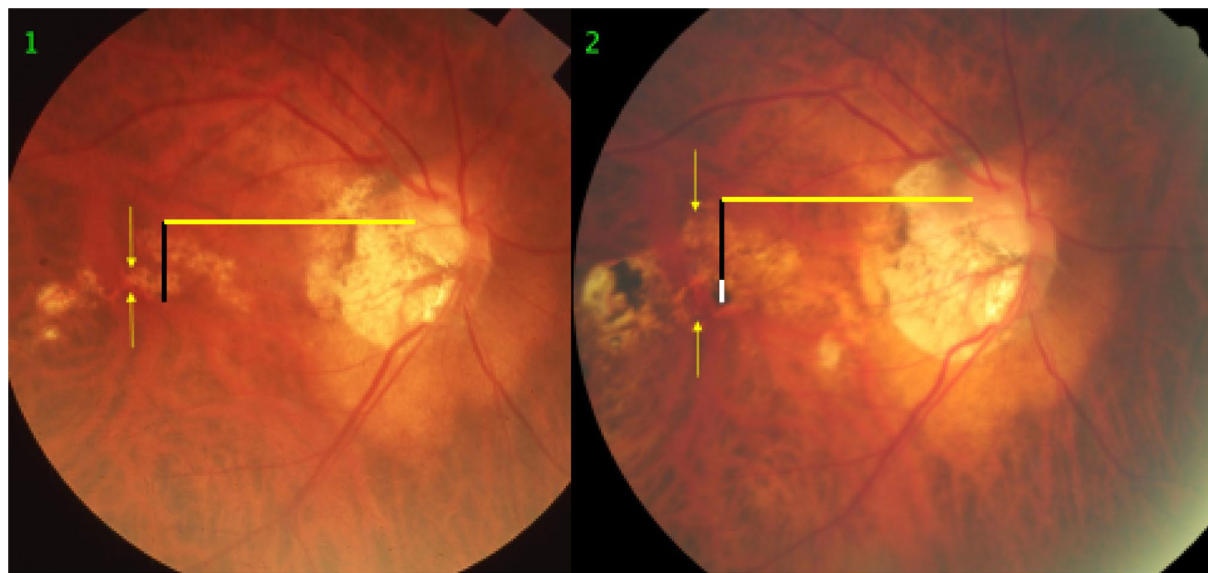
Figure 4. Fundus photographs of a highly myopic eye taken with an interval of 10 years (left image taken in 2001; right image taken in 2011). Note : enlargement of a diffuse chorioretinal atrophy /lacquer crack (yellow arrows) as category 2 of myopic macular degeneration. Elongation of the distance between two choroidal vascular markings, compared between baseline (vertical black bar) and follow up (equally long vertical black bar plus white bar), suggesting a spreading of the choroidal vessels. Distance between the choroidal marking and the disc border (equally long yellow bars) constant during follow-up. The choroidal vessel shift occurred perpendicular to the longest diameter of the area with diffuse chorioretinal atrophy/lacquer crack.